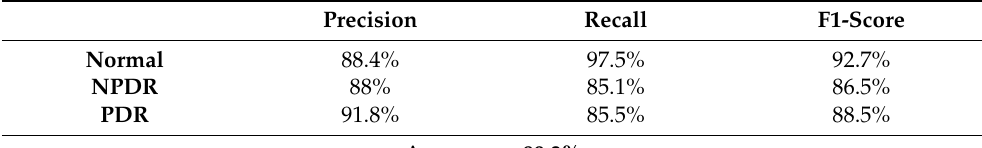
Table 4. Performance metrics of DenseNet121.